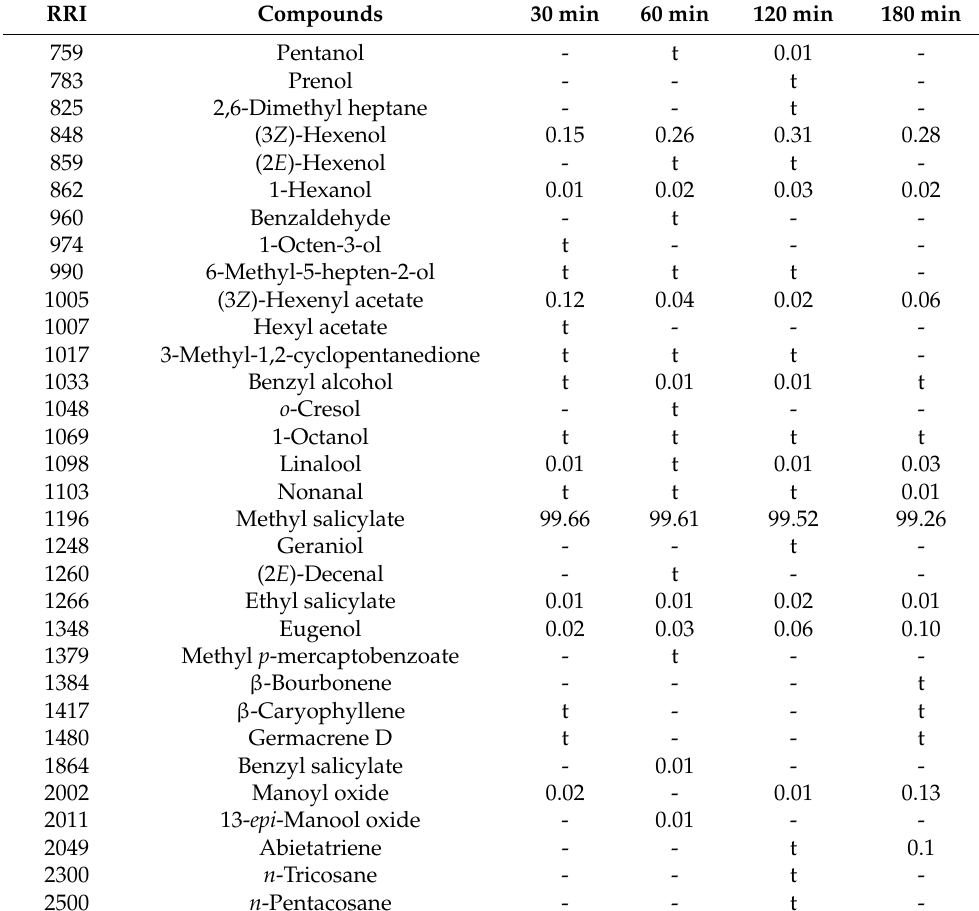
Table 3. Compositional analysis of wintergreen essential oil based on distillation time (in minutes); “-” indicates not detected and “t” indicates trace